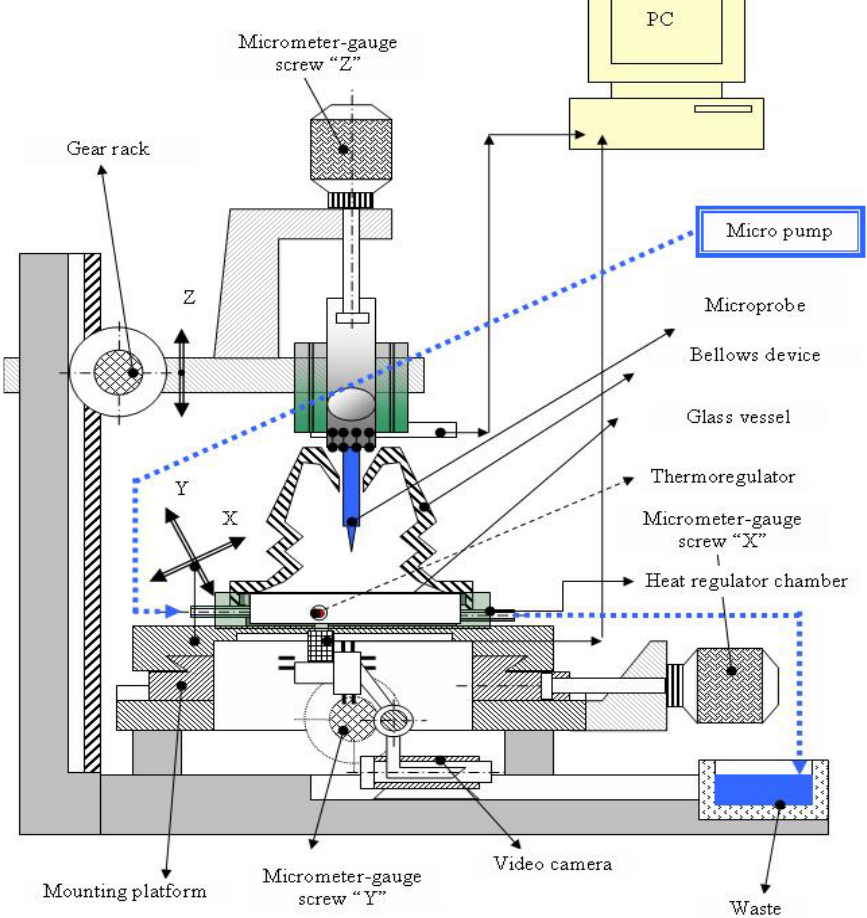
Figure 1. Scheme of the integrated